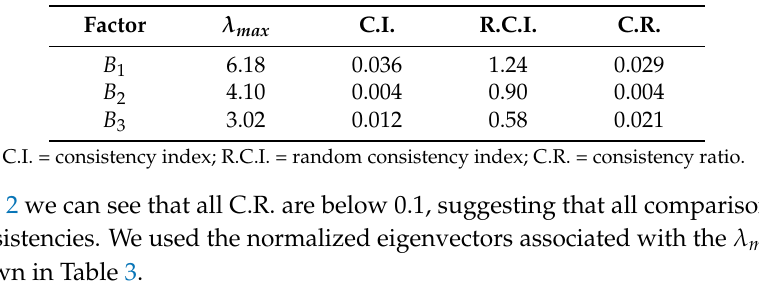
Table 2. Indices related to level 2 weights and consistency test.